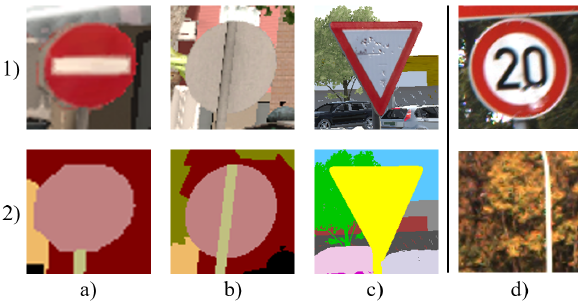
Figure 2. Synthetic image patches of traffic signs: 1a),